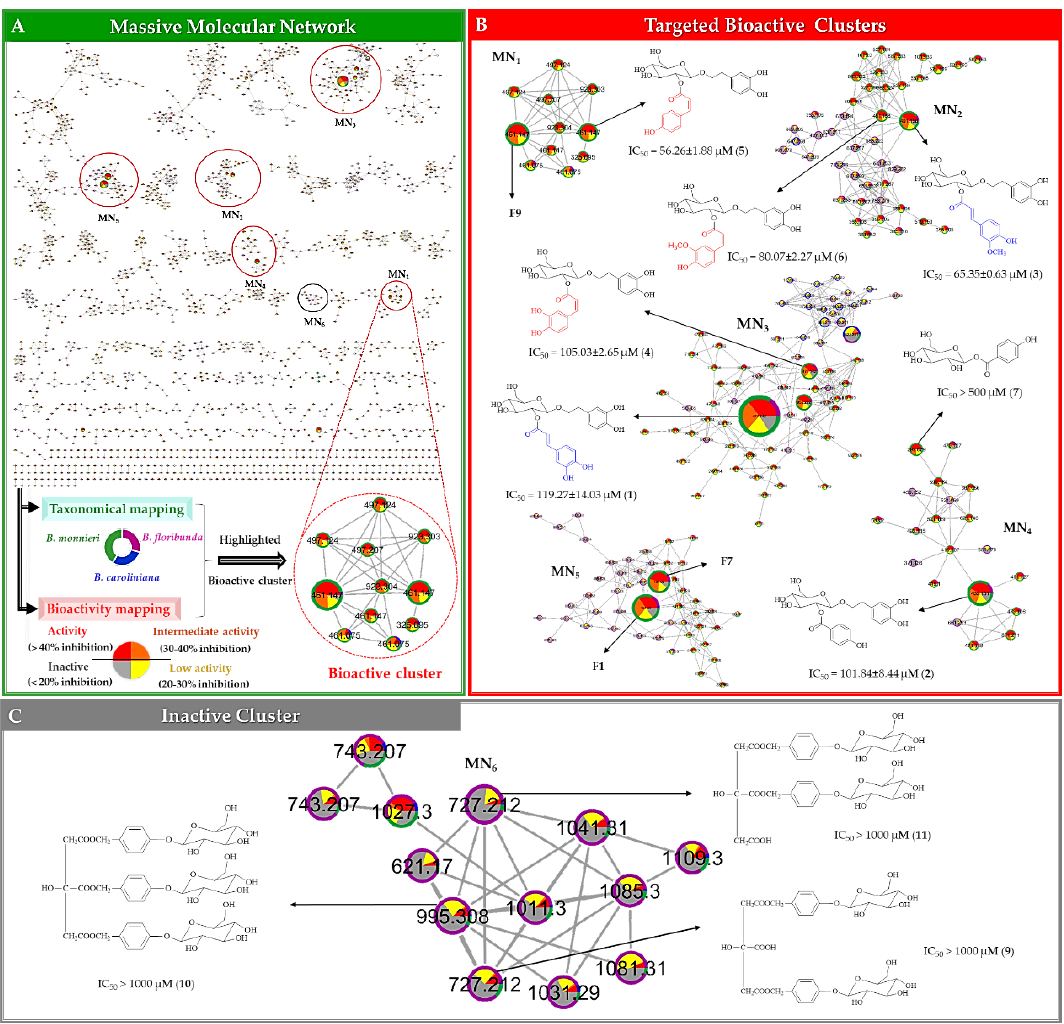
Figure 4. Multi - informational molecular map obtained from the analyses of 59 extracts of three Bacopa species mapping with taxonomy and anti - lipid peroxidation activity . Taxonomies of the samples are shown in di ff erent colors on the border of each node. Green, blue and purple represent BM, BC and BF, respectively. Bioactivities of the samples are shown in di ff erent colors inside each node. The active extracts with an inhibition higher than 40% are represented in red and inactive extracts with less than 40% inhibition are represented in gray. The size of each node is based on the peak height intensity. ( A ) A multi - informative massive molecular network created from MS 2 datasets . ( B ) Five selected bioactive clusters, MN 1 -MN 5 with two potential candidates in each cluster, ( C ) an inactive cluster, MN 6 . Chemical structures of the active compounds in Figure 4B,C are expressed with IC 50 values of anti-lipid peroxidation